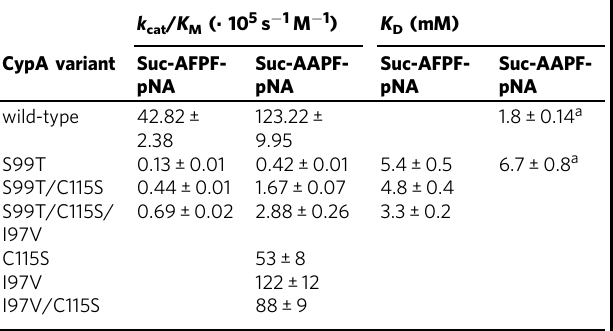
Table 1 Kinetic parameters and substrate af fi nity for wild- type CypA and mutants measured at 10